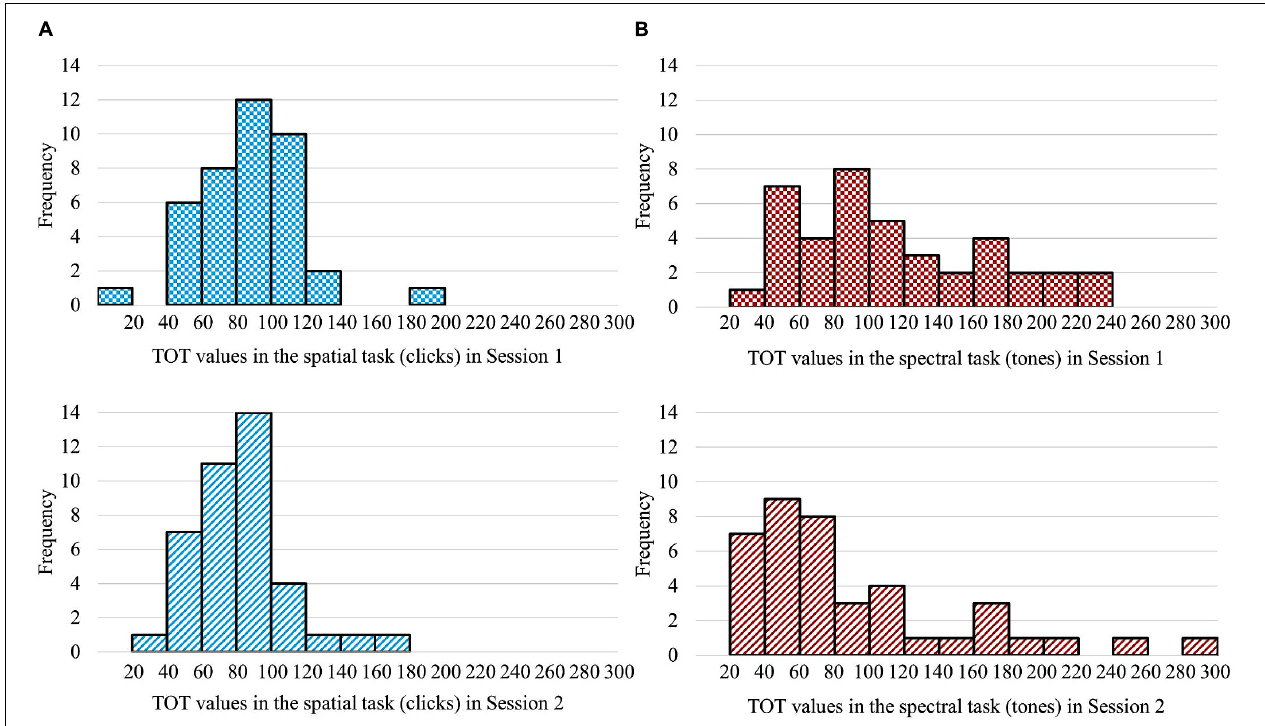
FIGURE 2 | Different distributions of ATOT data in particular subjects across the two TOJ tasks in consecutive sessions. Additional explanations: (A) The distribution of ATOT data in the spatial task was Gaussian ( skewness: 0.70 and 0.65; kurtosis: 2.85 and 0.95; Shapiro–Wilk test: 0.95 and 0.96 ). (B) The distribution deviated significantly from the Gaussian in the spectral task ( skewness: 0.60 and 1.52; kurtosis: –0.58 and 2.02; Shapiro–Wilk test: 0.94, p < 0.05 and 0.83, p < 0.001 ).